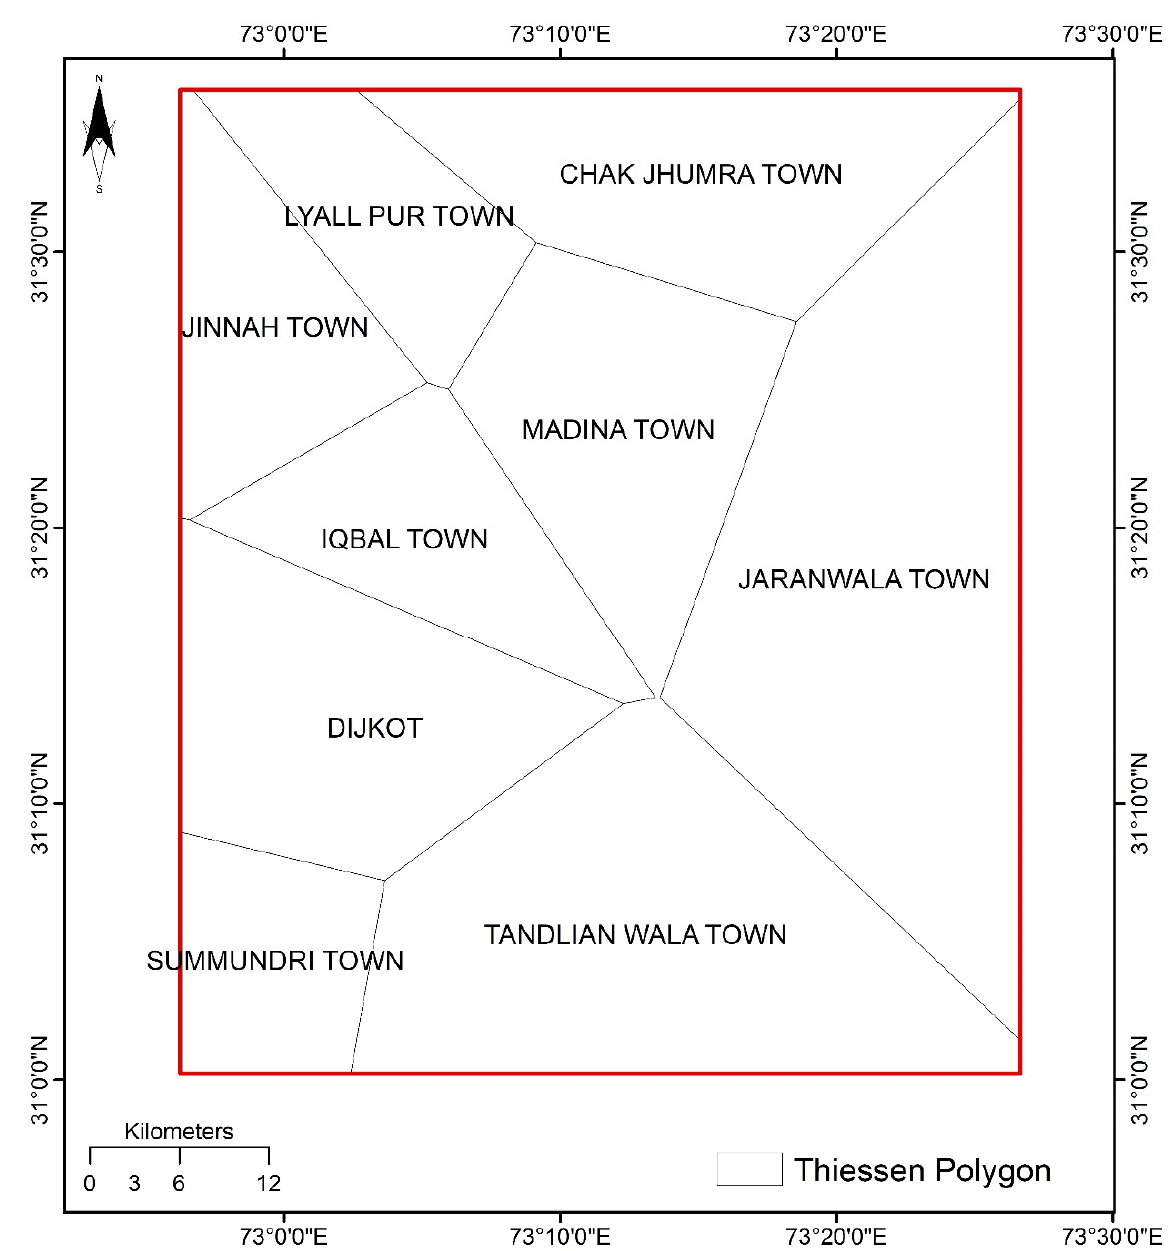
Figure 3. Thiessen polygons of the study area.